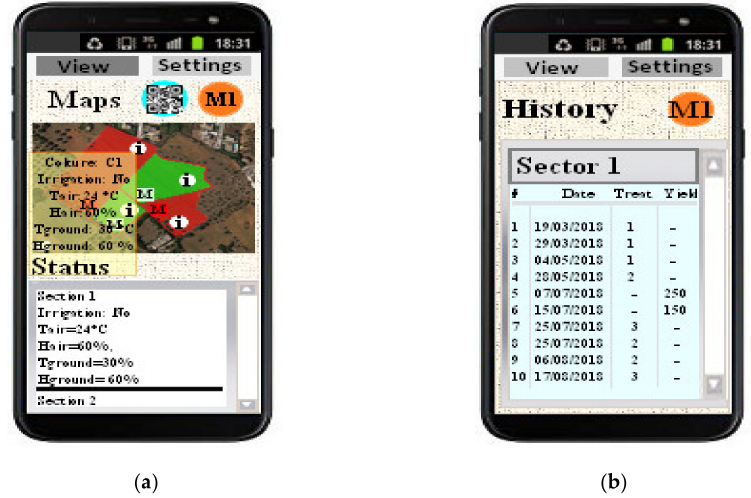
Figure 19. Screenshots of the realized application: “view section” where the farmer (user M1) has a complete overview of the cultivated crops ( a ) and “Data history section” through which the farmer or customer monitor crops’ parameters and the performed treatments for growth optimization ( b